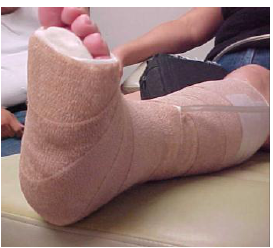
Figure 5. Application of multi-layer wrap at week seven.